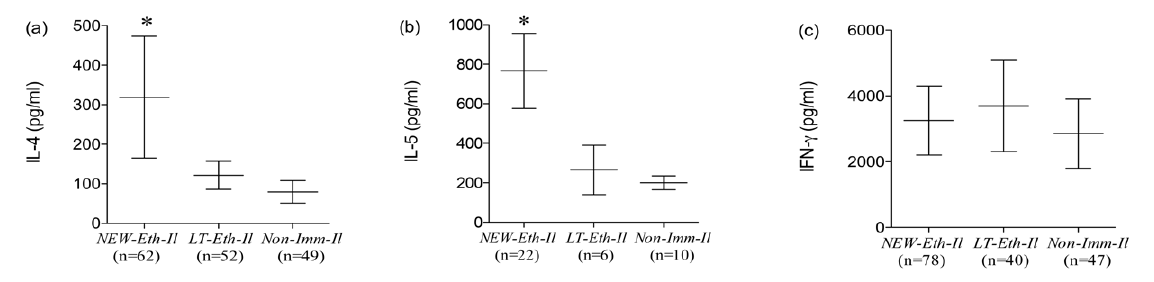
Figure 2. Cytokine Secretion by PHA stimulated PBMC of (a) NEW-Eth-Il , (b) LT-Eth-Il and (c) NON- Imm-Il groups. The horizontal middle line represents the median (50% of the data is greater than this value). The error bars show the 10th and 90th percentiles of the population (ie, the upper line is the maxi- mum greatest value [MGV] and the lower line is the minimum least value [MLV], excluding the outliers). The number of individuals examined is indicated below each group. The P value was determined by the Mann Whitney rank test ( P < 0.05 is statistically